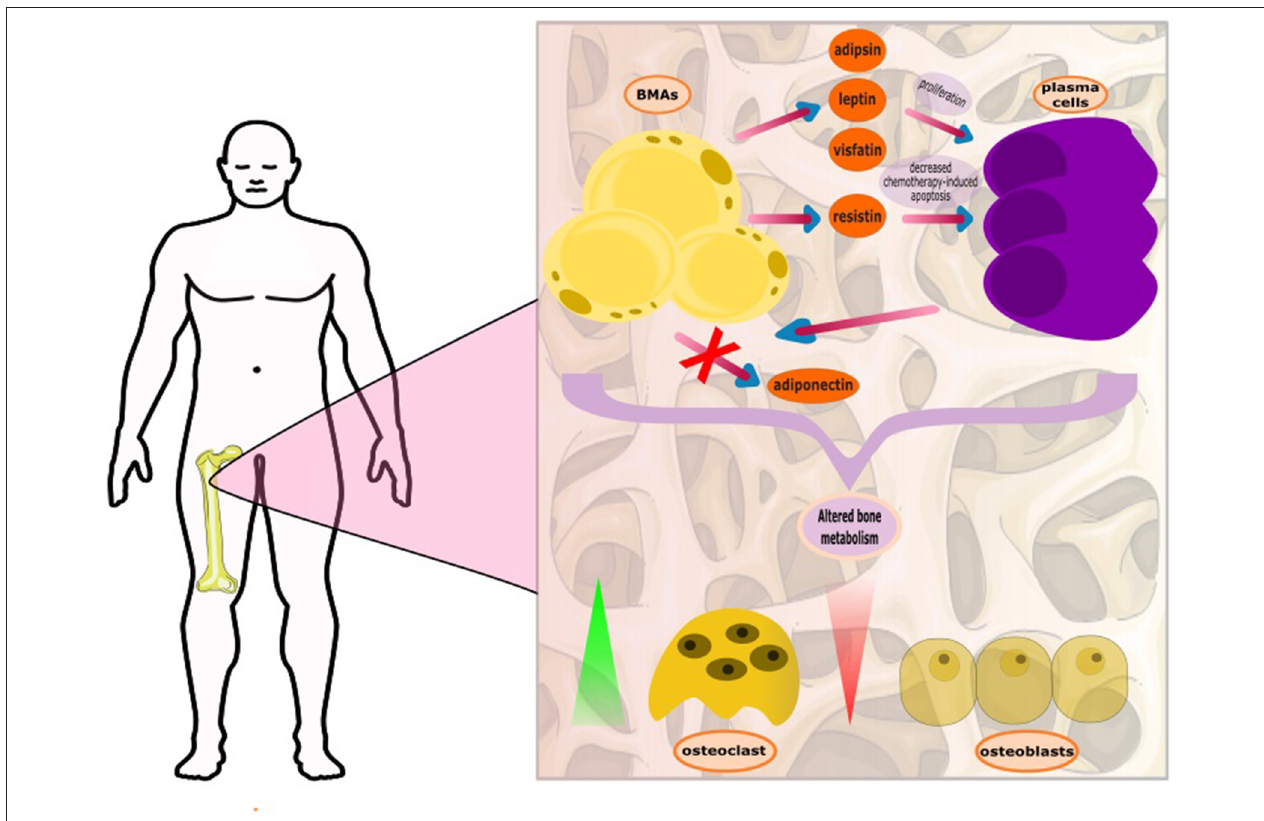
FIGURE 1 | The complex interplay between bone marrow adipocytes (BMAs) and plasma cells. The BMAs, through secretion of adipokines, support the growth and proliferation of the plasma cells. The plasma cells, with unknown mediator, appear to deter adiponectin production. Adiponectin is considered to block myelomatogenesis by reducing intracellular levels of nuclear factor kappa-light-chain-enhancer of activated B cells (NF-kB) and increasing the levels of anti-inflammatory cytokines. It has recently been found that plasma cells reprogram BMAs resulting in persistent bone